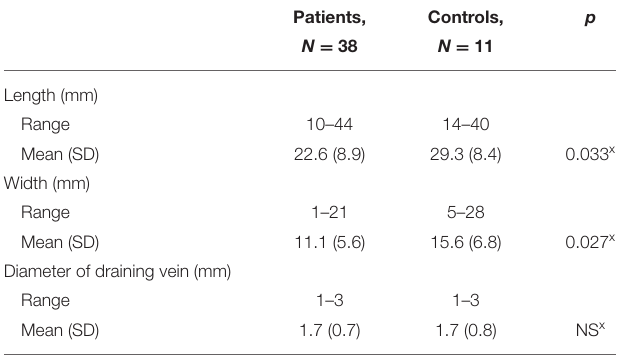
TABLE 3 | Extension of DVA’s in patients and